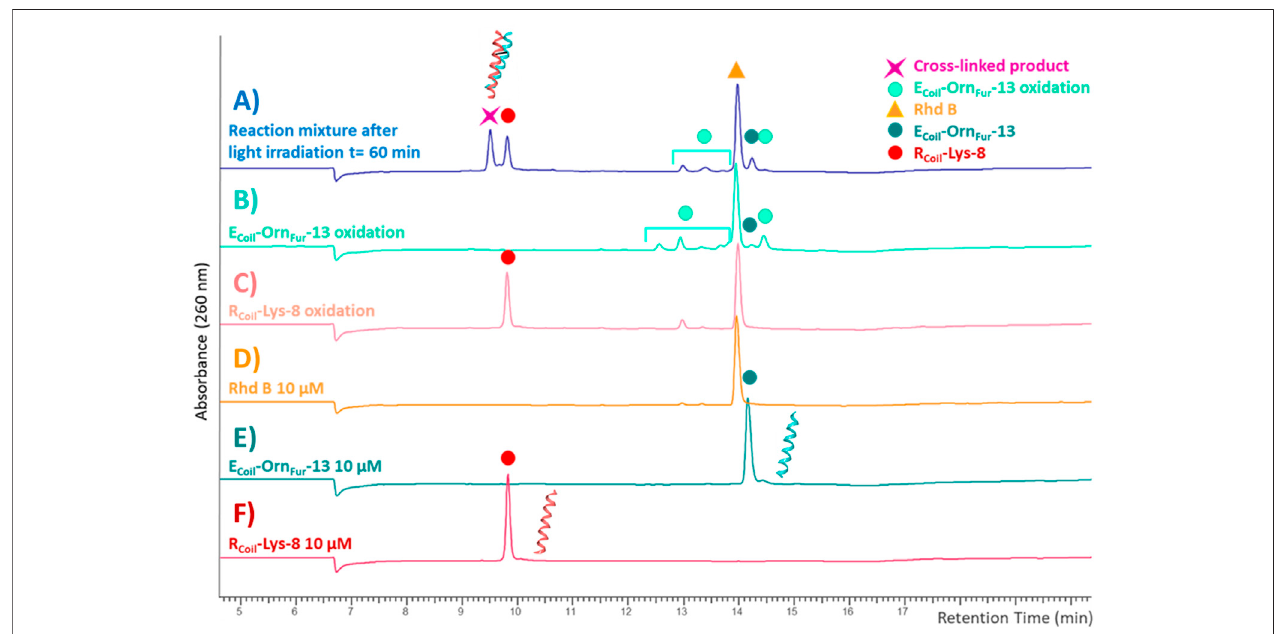
FIGURE 4 | HPLC-UV chromatograms recorded at 260 nm with a XTerra ® Shield RP18 column, 125 Å (5 μ M 2.1 × 250 mm). The reaction mixture after light irradiation[bluetrace (A) ]isthecross-linkreactionbetweenR Coil -Lys-8[redtrace (F) ]andE Coil -Orn Fur -13[dark greentrace (E) ]after60 minoflightirradiationwithRhdB [orangetrace (D) ]at10 μ M.TheR Coil -Lys-8oxidation(lightred)trace (C) andE Coil -Orn Fur -13oxidation(green)trace (B) weregeneratedbyexposuretosingletoxygenby light irradiation in the presence of Rhd B at 10 μ M for 60 min in absence of the other